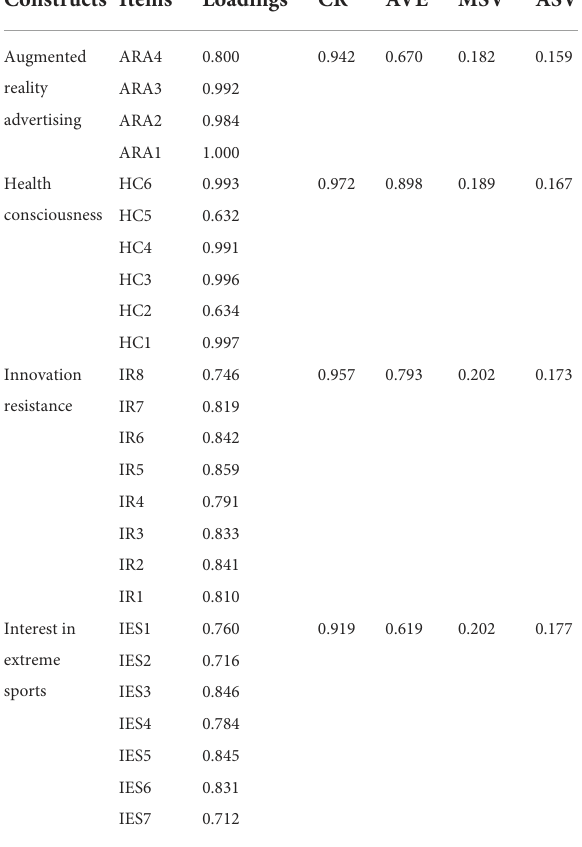
TABLE 2 Convergent